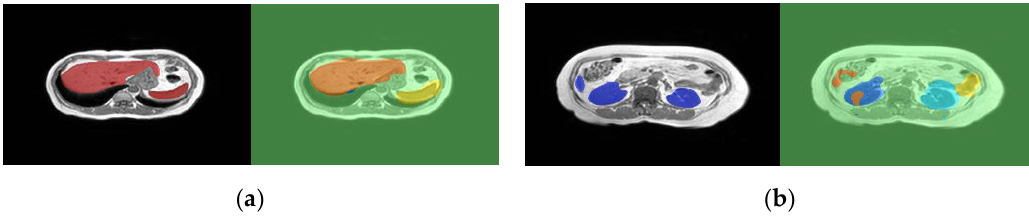
Figure 1. Example magnetic resonance image (MRI) segmentation of independent test images using DeepLabv3 segmen- tation network. The left of each image is the groundtruth on a black background, the right is the segmentation: ( a ) is a slice showing the liver and spleen; ( b ) is another slice showing the kidneys and a small extremity of the liver.